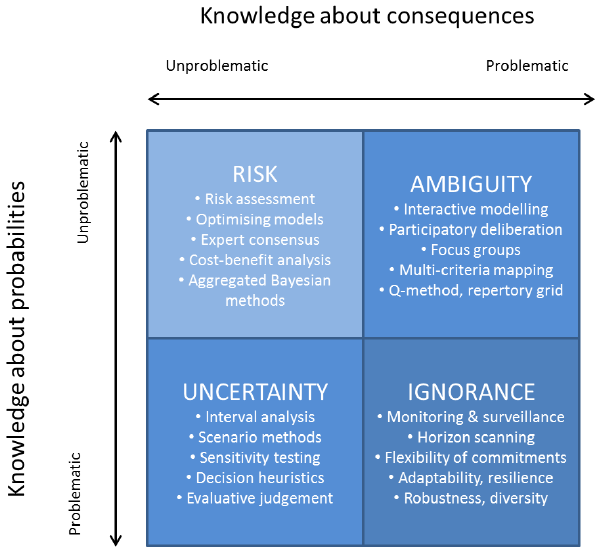
Figure 3. Methodological options for different epistemic condi- tions. Axes distinguish ways in which knowledge about risk may be incomplete and refer to the challenge posed by each category of incertitude for classical scientific approaches. For example, while quantification of uncertainty may be a useful tool when conse- quences are understood and there is good basis for assigning prob- abilities, it may have little relevance in situations that are charac- terised by ambiguity and ignorance. Adapted from Stirling